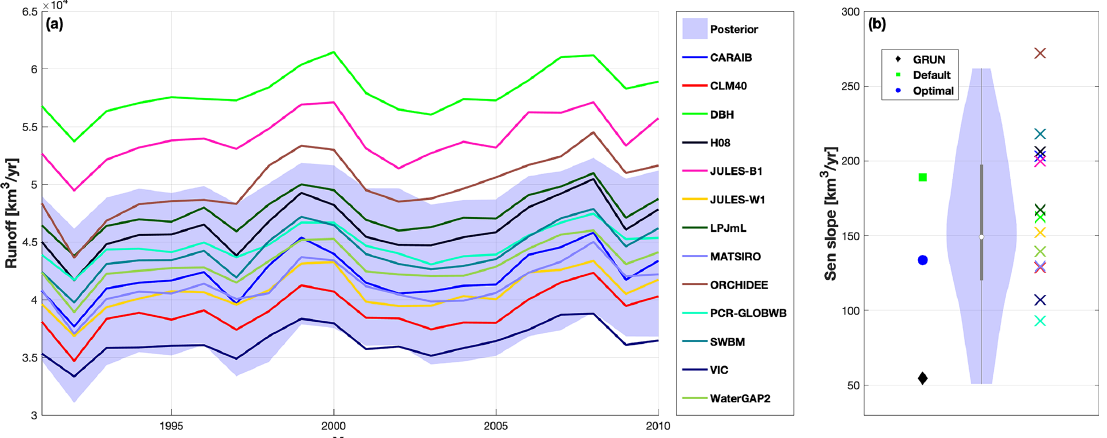
Figure 12. (a) Annual global runoff from 13 global hydrological models participated in ISIMIP2a and ELM simulated runoff uncertainty constructed using simulations with parameter posteriors. (b) Sen’s slope for the global annual runoff for the GRUN runoff dataset and simulations. The violin plots (Hintze and Nelson, 1998) are generated with Sen’s slope of ELM simulations with parameter posteriors. The white point is the median value, and the gray line represents range of the 25%–75% percentile. The MATLAB function of Bechtold (2016) was used to create the violin plot. The cross signs are the Sen’s slopes estimated from the ISIMIP2a model simulations.